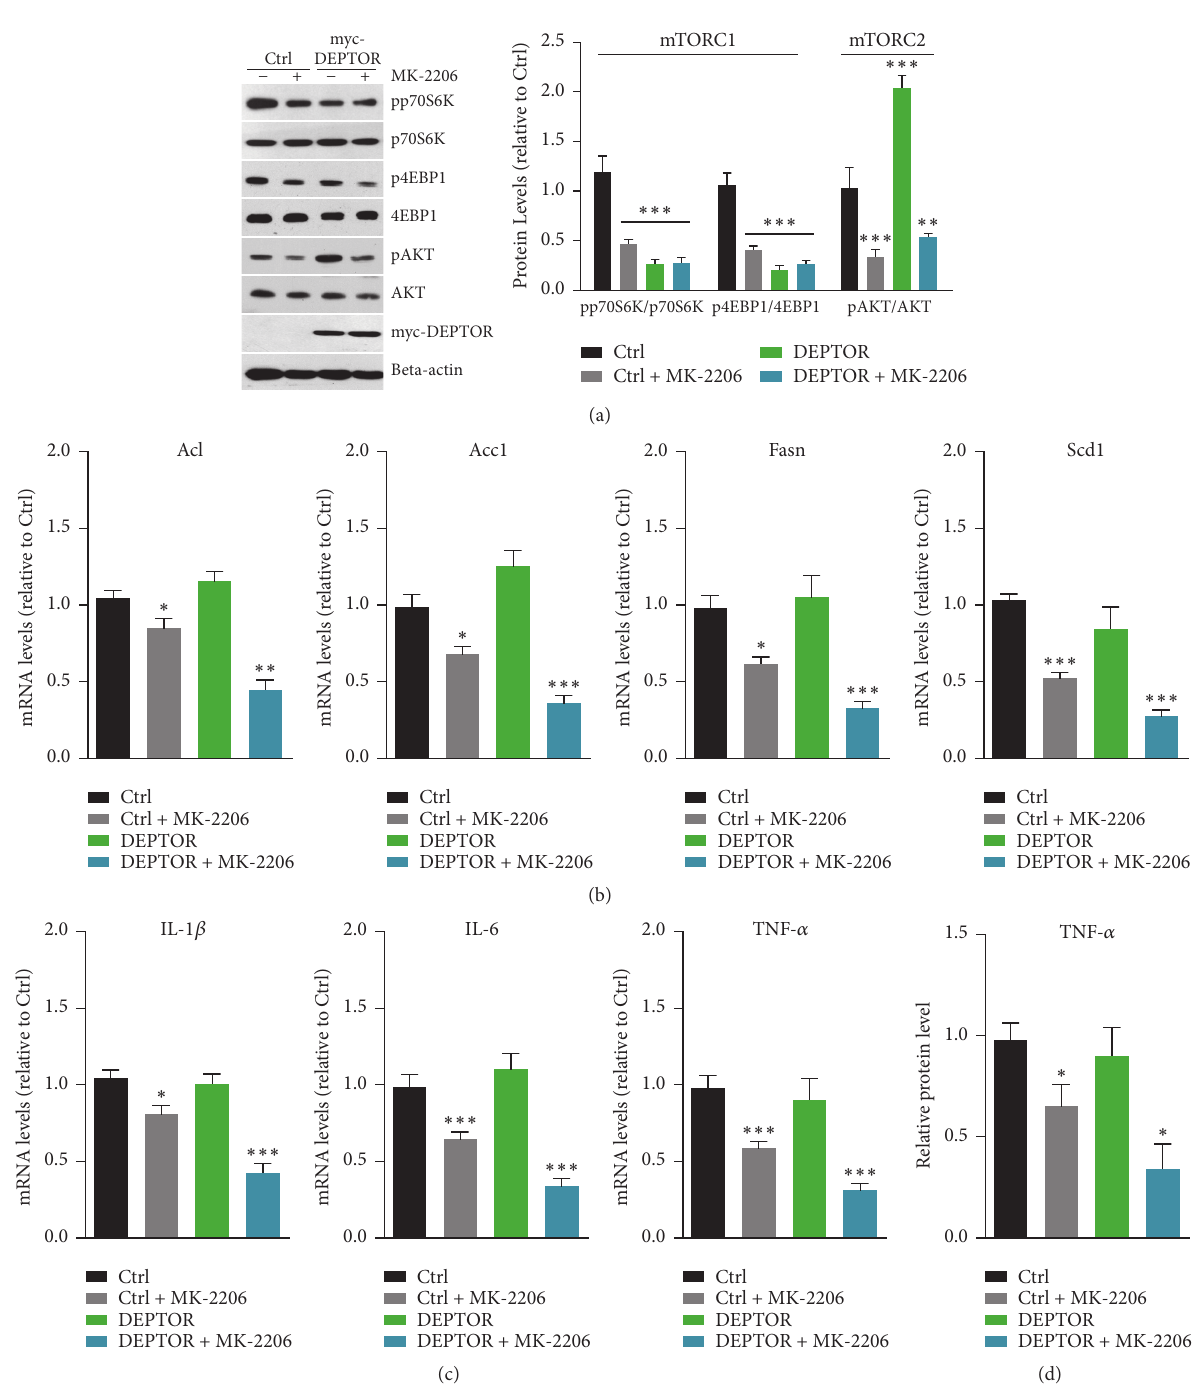
Figure 3: AKT inhibitors downregulate lipogenesis and inflammation in DEPTOR overexpressed cells. (a) Western blots and quantifications showed that mTORC1 activity, indicated by phosphorylations of p70S6K and 4EBP1, was downregulated by myc-DEPTOR overexpression and MK-2206 (1 𝜇 M for 4 hours, same as follows) conditions. However, mTORC2 activity (indicated by pAKT/AKT) was blocked by MK- 2206 treatment in lymphocytes of PBMC culture. Results are averages of three independent experiments. Data represent mean ± SEM. Data represent mean ± SEM. ∗∗ 𝑃 < 0.01 and ∗∗∗ 𝑃 < 0.001 . (b) Real-time RCR results showed that mRNA levels of lipogenesis genes, including Acl, Acc1, Fasn, and Scd1, were dramatically reduced in MK-2206 treated DEPTOR overexpressed cells. Results are averages of three independent experiments. Data represent mean ± SEM. Data represent mean ± SEM. ∗ 𝑃 < 0.05 , ∗∗ 𝑃 < 0.01 , and ∗∗∗ 𝑃 < 0.001 . (c) Real-time RCR results showed that mRNA levels of inflammation genes, including IL1- 𝛽 , IL-6, and TNF- 𝛼 , were dramatically reduced in MK-2206 treated DEPTOR overexpressed cells. Results are averages of three independent experiments. Data represent mean ± SEM. ∗ 𝑃 < 0.05 and ∗∗∗ 𝑃 < 0.001 . (d) ELISA results showed that protein levels of TNF- 𝛼 were decreased in MK-2206 treated DEPTOR overexpressed cells. Results are averages of three independent experiments. Data represent mean ± SEM. ∗ 𝑃 < 0.05